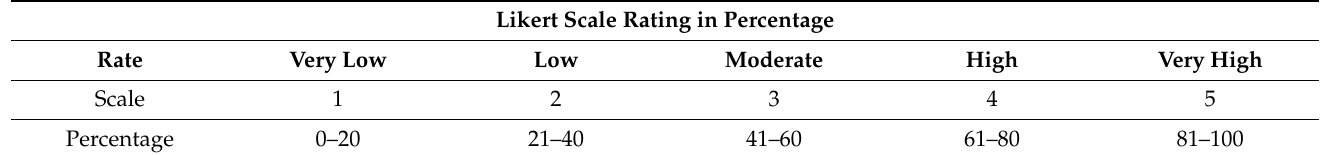
Table 2. Likert scale rating in